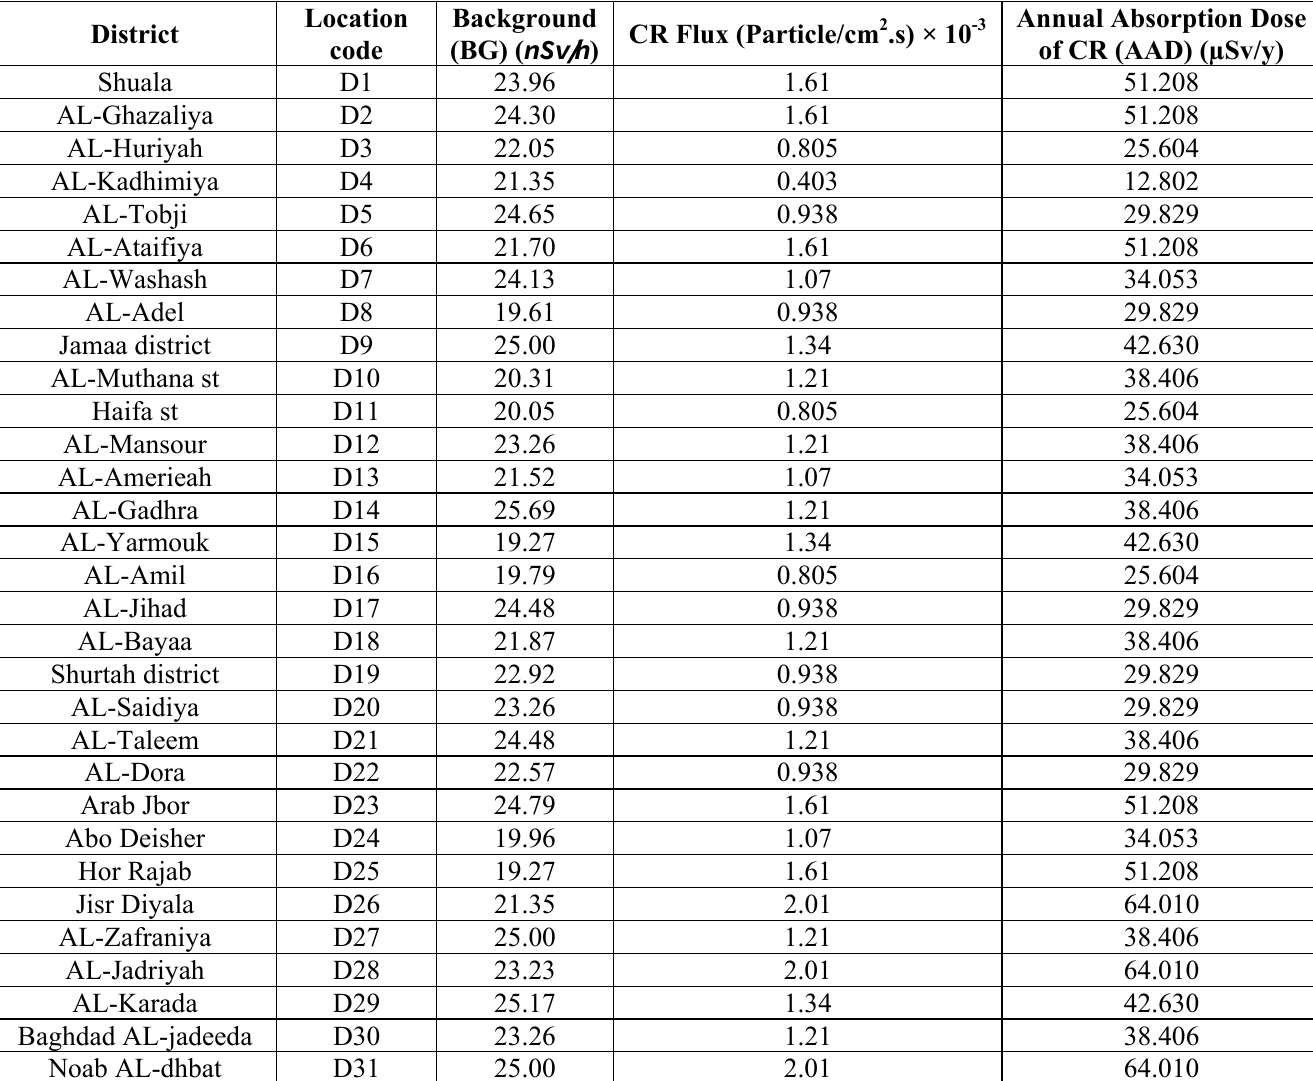
Table 1: The overall results of radiation background, cosmic ray flux, and the unshielded annual absorption dose of human phantom due to cosmic ray for districts of Baghdad